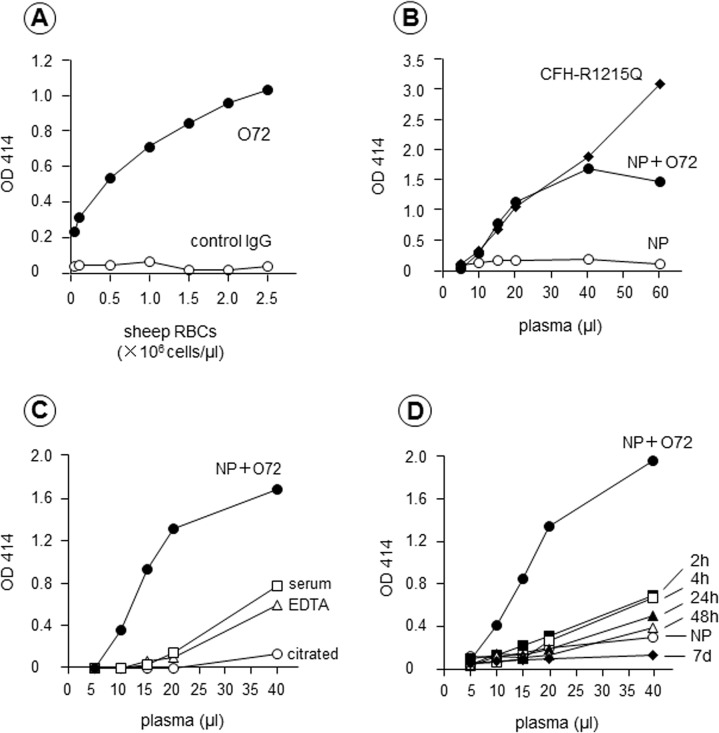
Optimization of the hemolytic assay: sheep red blood cells (RBCs) concentration, anti-complement factor H (CFH) monoclonal antibody (mAb) O72, and blood specimen type.
(A) Evaluation of the optimal sheep RBC count. Various counts of sheep RBCs were incubated with 20 μl of normal plasma spiked with anti-CFH mAb O72 (200 μg IgG/ml, NP + O72) or control IgG. Maximum hemolysis was observed at the sheep RBC count of 2.5×106/μl; thus, all subsequent experiments were performed using this sheep RBC count. (B) Comparison of hemolysis induced by mAb O72 and CFH mutant protein. The degree of hemolysis caused by normal plasma spiked with mAb O72 or plasma from a patient with a CFH-p.R1215Q mutation was quite comparable up to 40 μl. (C) Screening of optimal blood specimen type. Three different specimens (serum, EDTA plasma, and citrated plasma) from one healthy donor were analyzed using the hemolytic assay. Citrated normal plasma spiked with mAb O72 was used as a positive control. In serum and EDTA plasma, mild hemolysis of sheep RBCs was detected at 40μl. No appreciable hemolysis was observed at any volume of citrated plasma. (D) Evaluation of the influence of the coagulation time interval on hemolytic reaction. Serum obtained 2 and 4 hours after blood collection showed mildly enhanced hemolysis at 40 μl. This mild hemolysis was lower in serum obtained 24 and 48 hours prior. No appreciable hemolysis was detected in serum obtained 7 days prior.